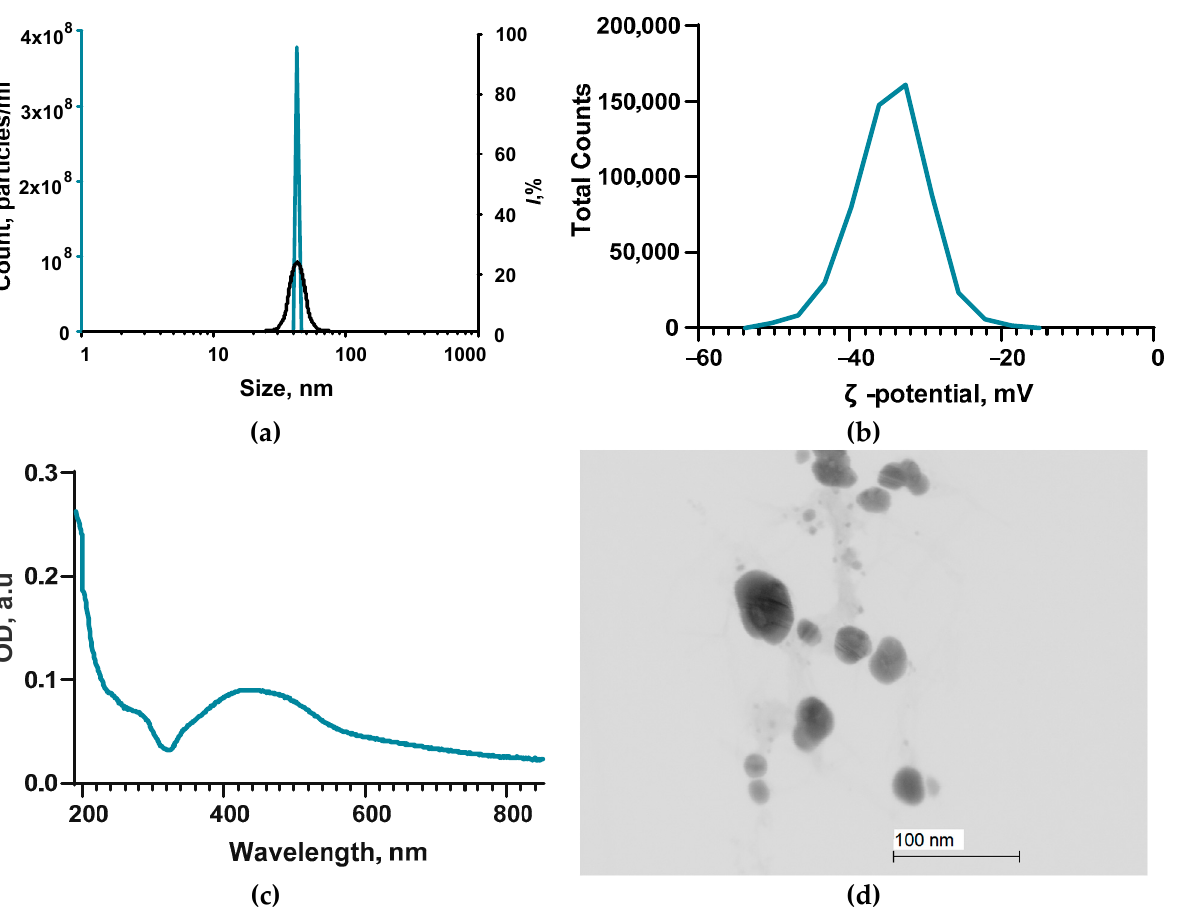
Figure 1. Main characteristics of Ag 2 O NPs: ( a ) Size distribution of NPs obtained by DLS (blue line) and CPS (black line). ( b ) NP distribution over the ζ -potential obtained by the ELS method. ( c ) Absorption spectrum from the UV–vis region of the NP colloid. ( d ) TEM photograph of the obtained NPs. Scale bar: 100 nm.